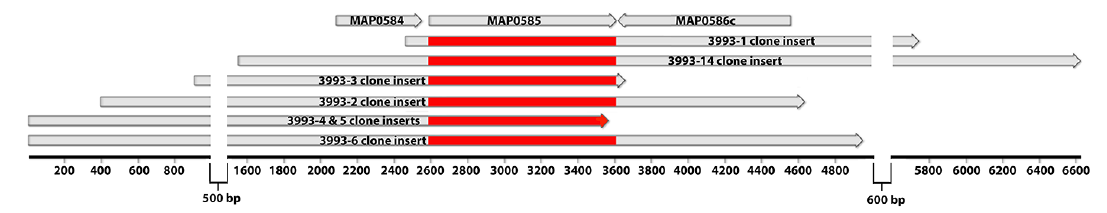
Figure 8. Sequence alignment of positive clone inserts from a Map phage expression library. Shown are the DNA inserts subcloned from positive plaques obtained from the library screen. Subcloned inserts are aligned and drawn relative to a base pair scale that spans 6.6 kb. There is a 500 and 600 bp break in the scale to amplify the region of interest. The top row shows the coding sequences from the Map genome and their relative positions among the library clones. Highlighted in red is the region of the respective clones that overlap with the coding sequence MAP_0585. Only this coding sequence was universally present in all the clones.